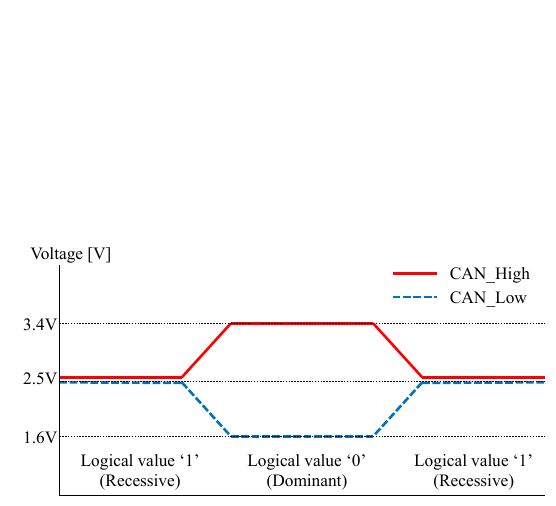
Fig. 1. Example of a spoofing attack on